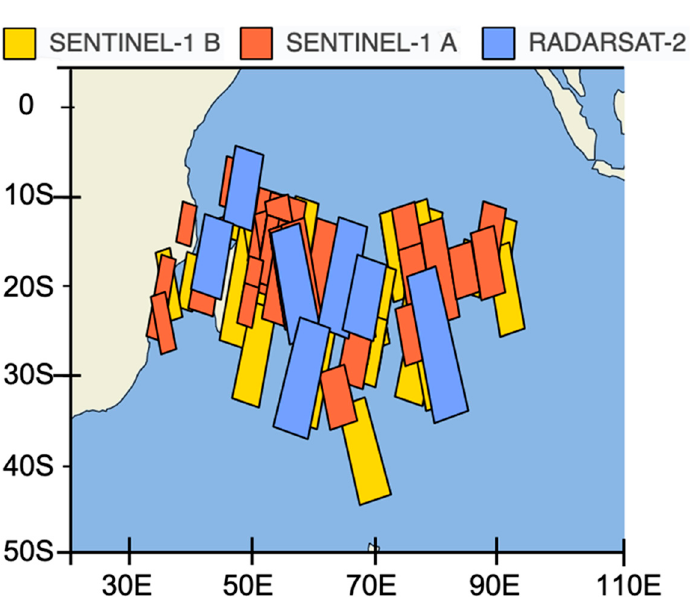
Figure 23. Location of Sentinel-1 (A and B) and RADARSAT-2 swaths listed in Table 2. Examples of SAR-derived surface wind fields obtained through the application of the retrieval algorithm proposed by [126] are presented hereafter. The first example was taken within TC JOANINHA, which developed in the northeastern part of the Mascarene Archipelago (Figure 17a) and reached its LMI in the vicinity of Rodrigues Island on 26 March 2019, with 10 min of maximum sustained winds of nearly 60 m s − 1 (Figure 24a). The core structure of this system was observed seven times by the SAR systems deployed onboard satellites S1A/S1B and RS2 (Table 2) at various stages of its life cycle. Of particular interest is the image taken by RS2 on 28 March 2019 at 00:52 UTC (Figure 24b), when the system started to experience an eyewall replacement cycle (ERC). The latter, which often occurs when a TC reaches an intensity of 50 m s − 1 , has long been recognized as one of the main mechanisms for intense TCs to intensify further [127,128]. During an ERC, outer rainbands strengthen and organize themselves into a ring of thunderstorms that progressively encircle the TC eyewall. The formation of this outer ring, usually referred to as the outer eyewall, eventually cuts off the supply of moisture and angular momentum that maintain convection around the eye, causing a weakening of the system and the eventual dissipation of the inner eyewall. The former ring is then replaced by the